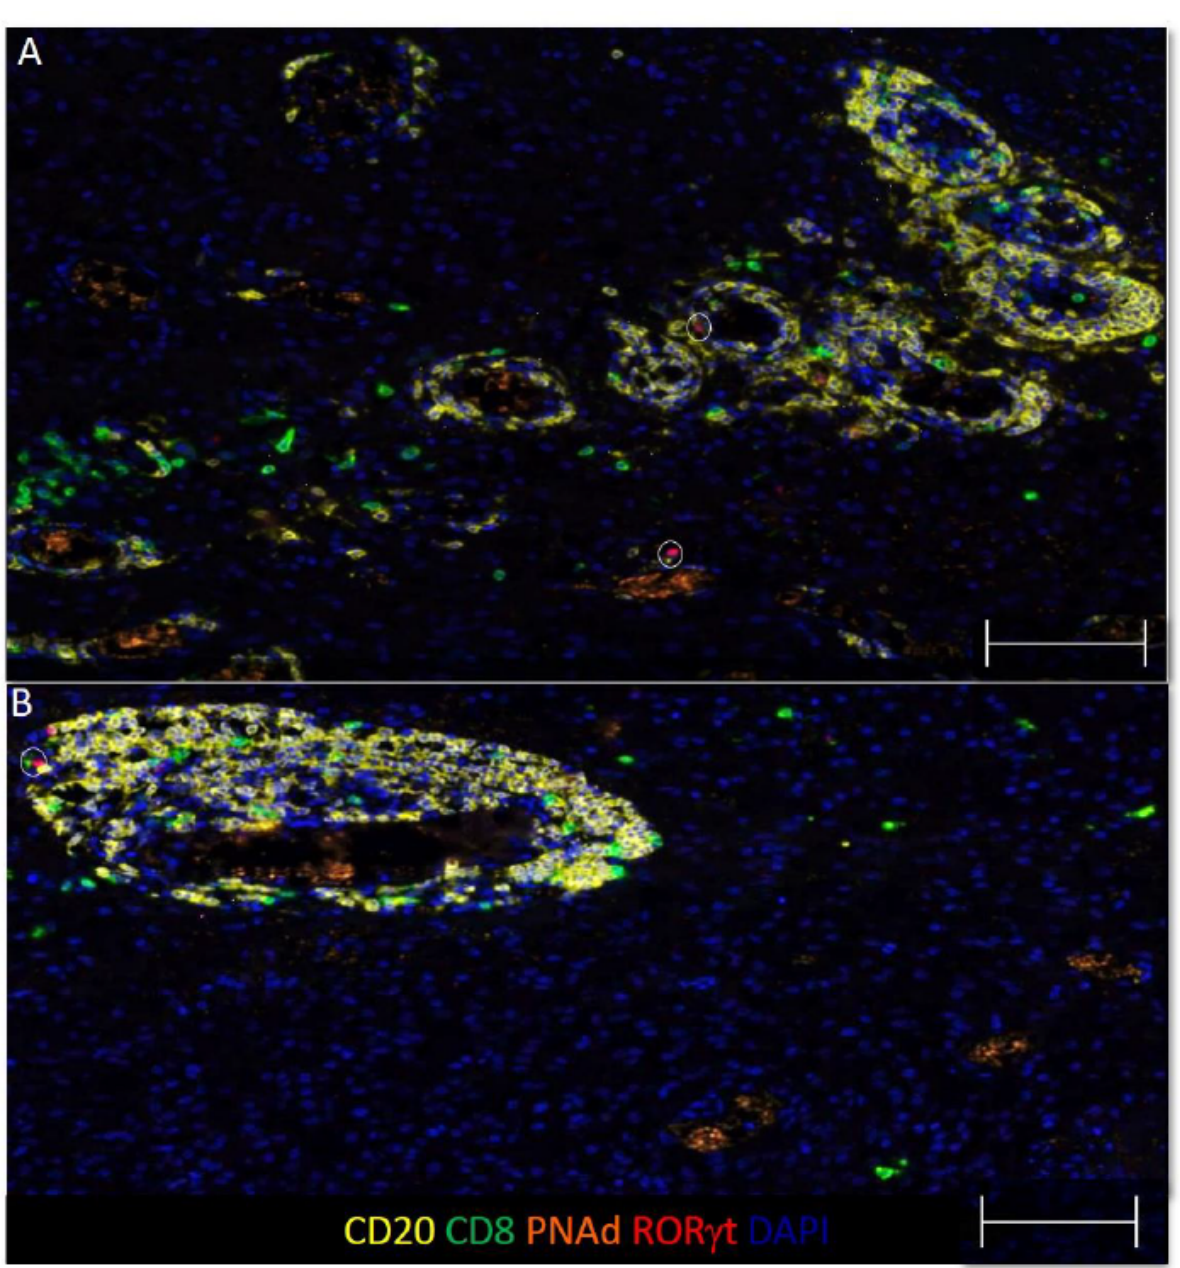
Figure 2. GBM contain focal B and T cell aggregates resembling immature TLS. ( A , B ) Representative images of dense clusters of CD20 + B cells, CD8 + T cells, and PNAd + vasculature from two GBM specimens. The circles denote ROR γ t + cells, scale bars are 100 µ m and colors are